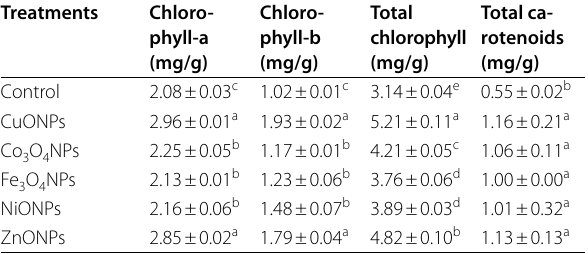
Table 6 Impact of NPs on chlorophyl-a, chlorophyll-b, total chlorophyll, and total carotenoids of P. vulgaris